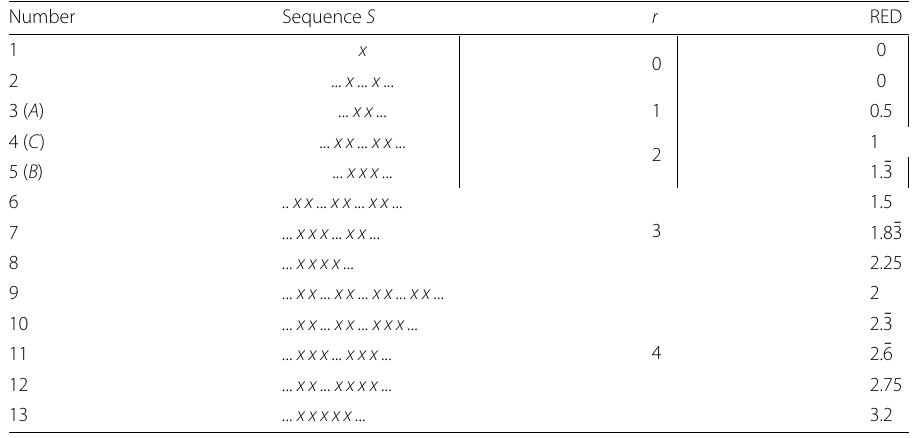
Table 4 RED values for all combinations of 0–4 repeated errors r ( A , B , C correspond to students